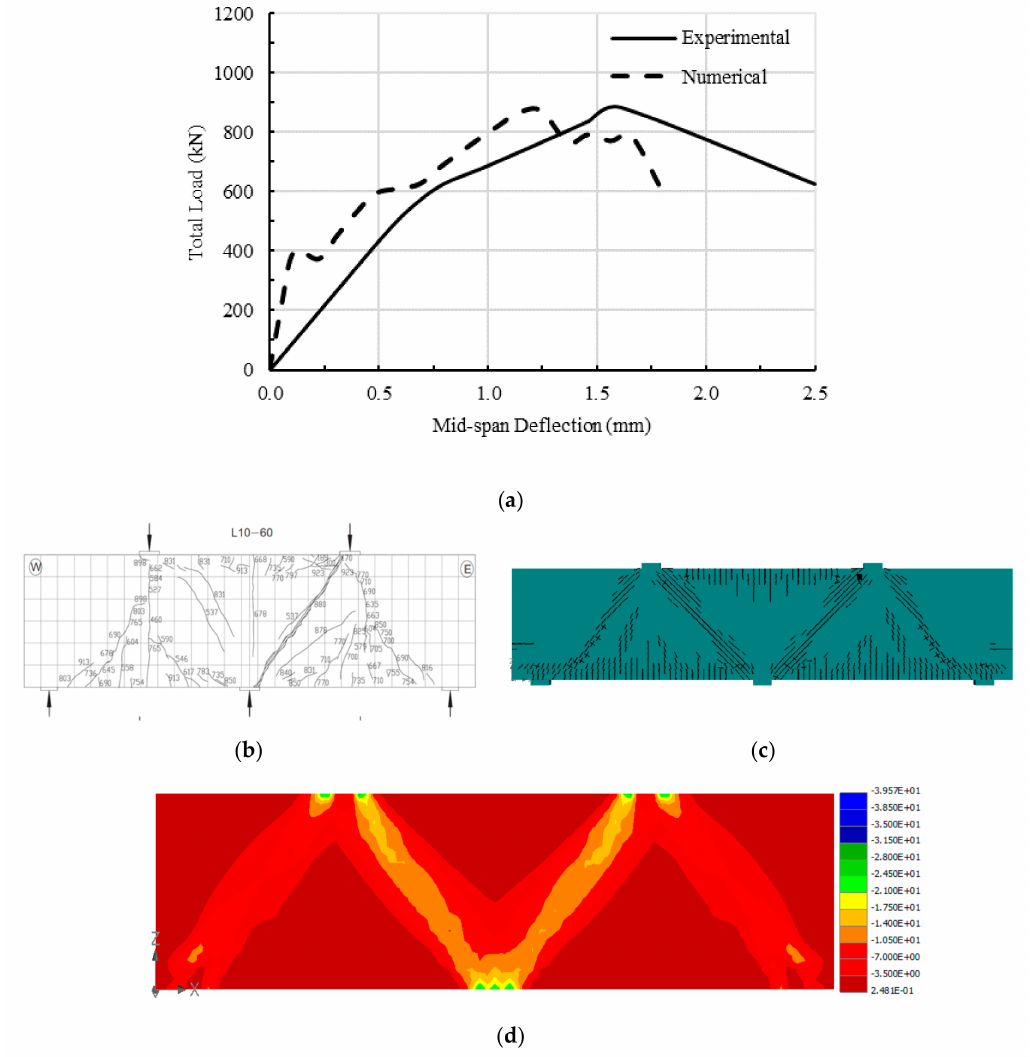
Figure 7. Experimental and numerical responses of specimen L10-60 (RHR supports): ( a ) Experimental [9] and numerical load-deflection curves for specimen L10-60; ( b ) experimental crack pattern [9]; ( c ) numerical crack pattern; ( d ) stress distribution